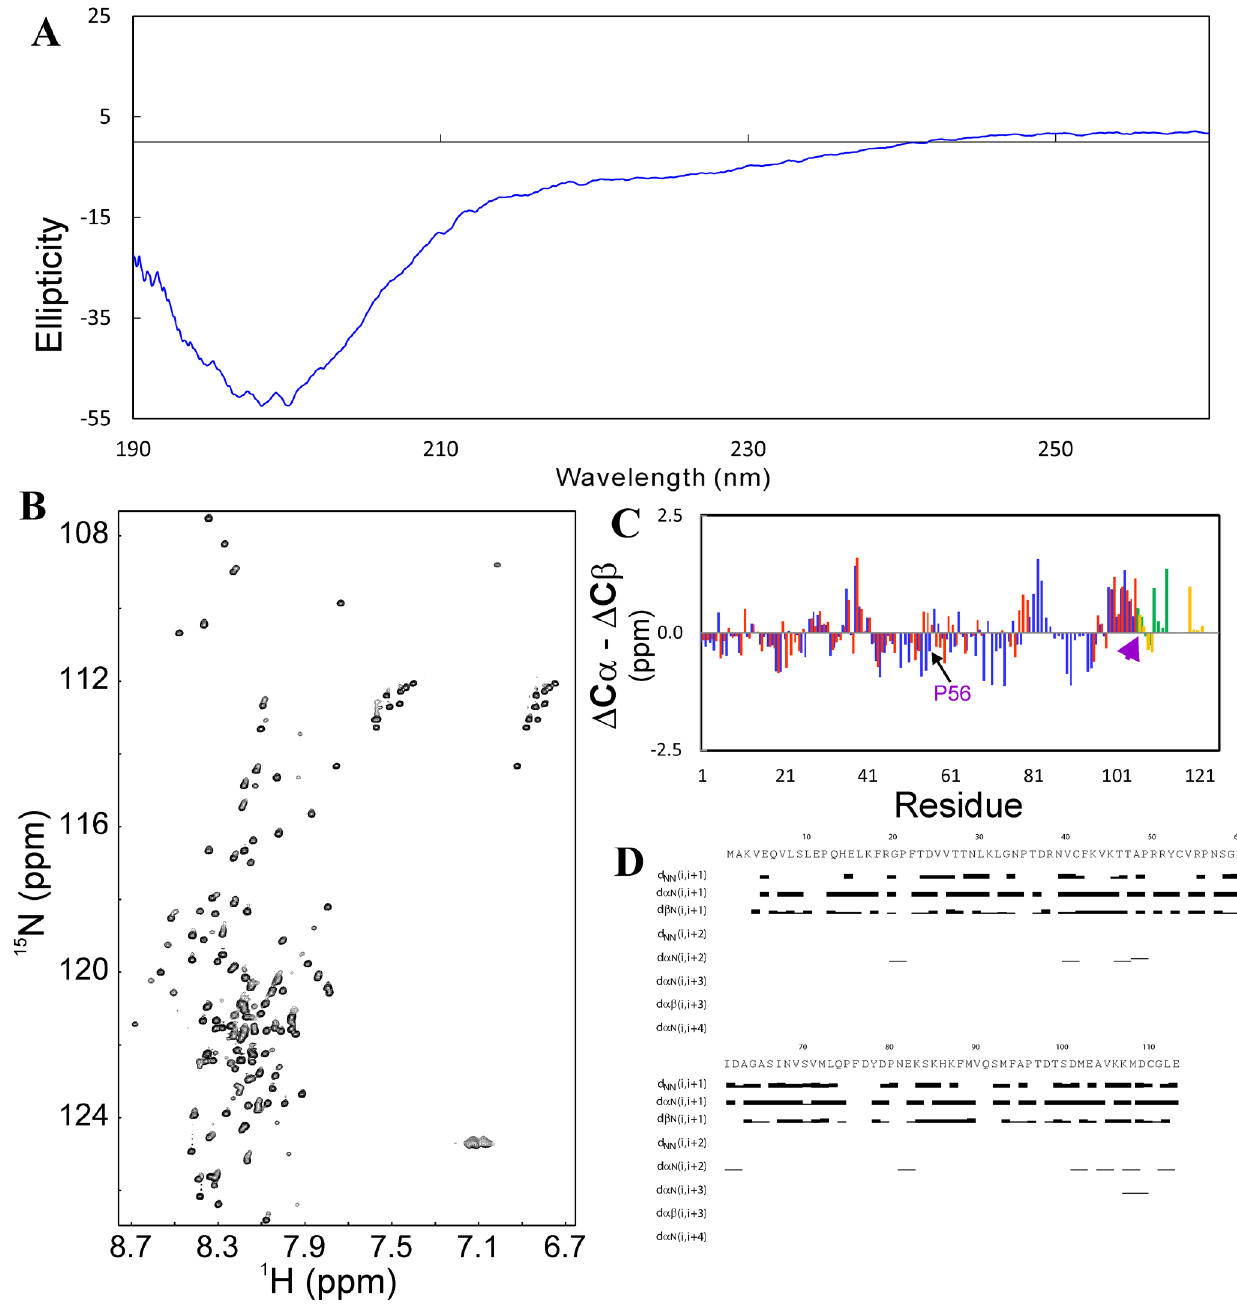
Figure 4. Conformational properties of VAPB-3 solubilized in unsalted water. ( A ) Far-UV CD spectrum. ( B ) 1 H– 15 N NMR HSQC spectrum acquired at 25 ° C. ( C ) Residue-specific ( Δ C α – Δ C β ) values of VAPB-3 and P56S-MSP. For VAPB-3, blue bars are used to indicate ( Δ C α – Δ C β ) values for the first 105 residues identical to those of MSP, while green bars for unique residues. For P56S-MSP, red bars are used to indicate ( Δ C α – Δ C β ) values for the first 105 residues, while brown bars for the C-terminal 20 residues. ( D ) NOE connectivity pattern of VAPB-3 defining secondary